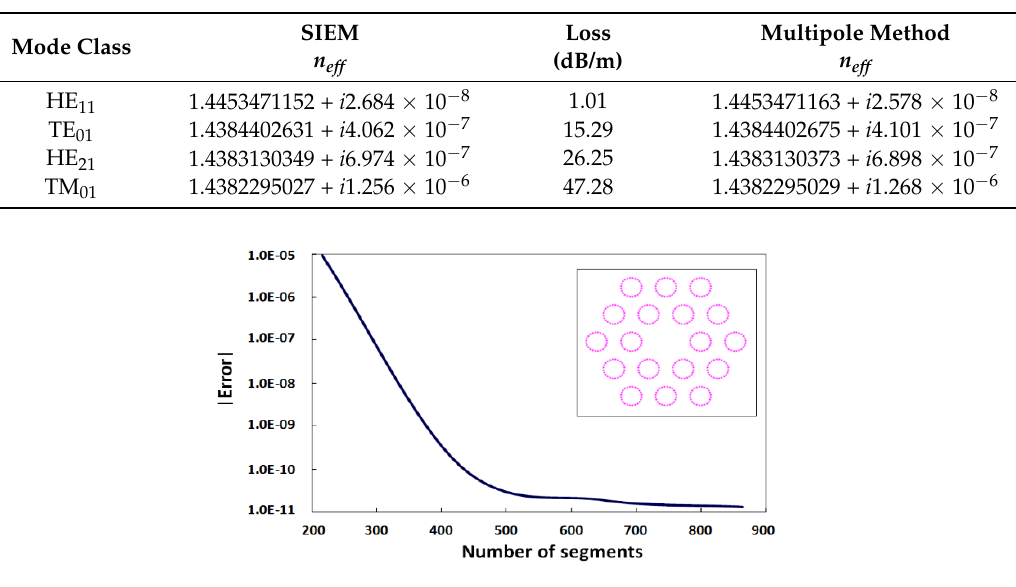
Table 1. Comparison of mode class, complex effective index, and confinement loss for the algorithm based on the surface integral equation method (SIEM) and the multipole method [27] in Figure 1a.